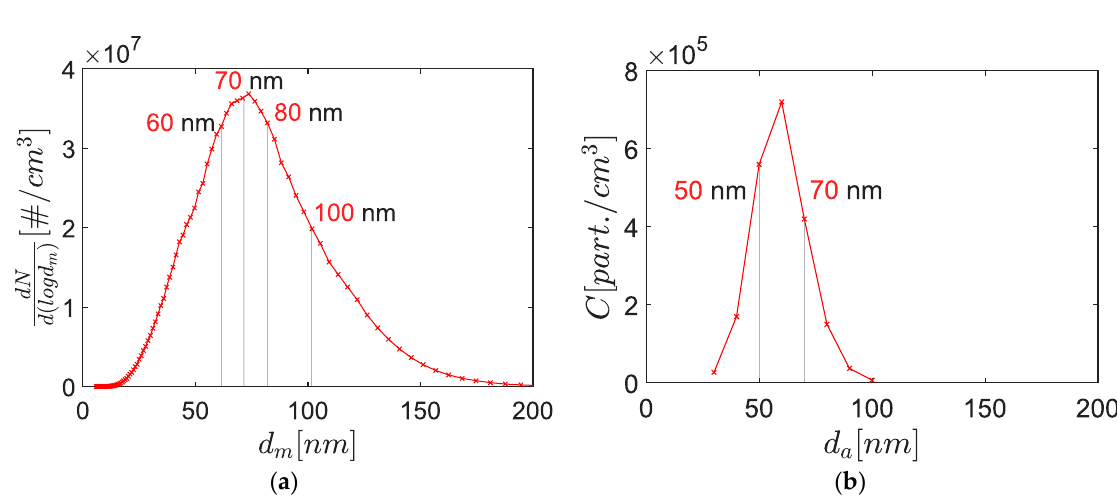
Figure 4. ( a ) Mobility diameter size distribution of a poly-disperse aerosol generated by the mini-CAST. The measurements are performed using a Scanning Mobility Particle Sizer (SMPS); ( b ) Aerodynamic diameter size distribution of the same aerosol measured downstream of an AAC with a CPC.